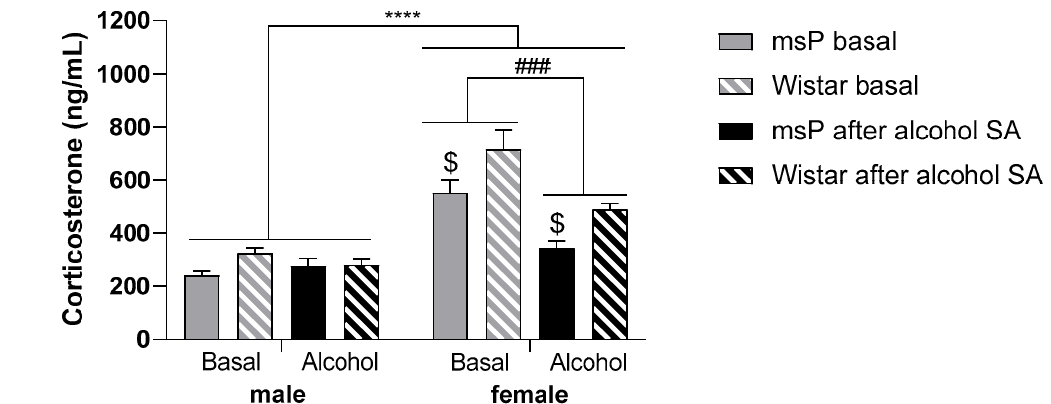
Figure 3. Blood corticosterone (CORT) levels under basal conditions and after alcohol SA sessions in male and female msP and Wistar rats. Females displayed significantly higher blood CORT levels than males independently of rat strain. Female Wistars had higher CORT levels than female msPs. Alcohol consumption decreased basal CORT levels in female animals only. In both rat lines, CORT levels of male rats remained unchanged following alcohol SA. Data are presented as mean ± SEM. Main effect of sex: **** p < 0.0001; main effect of sex x alcohol condition: ### p < 0.001; $ p < 0.05 vs. msP same condition and sex (sex x strain interaction).